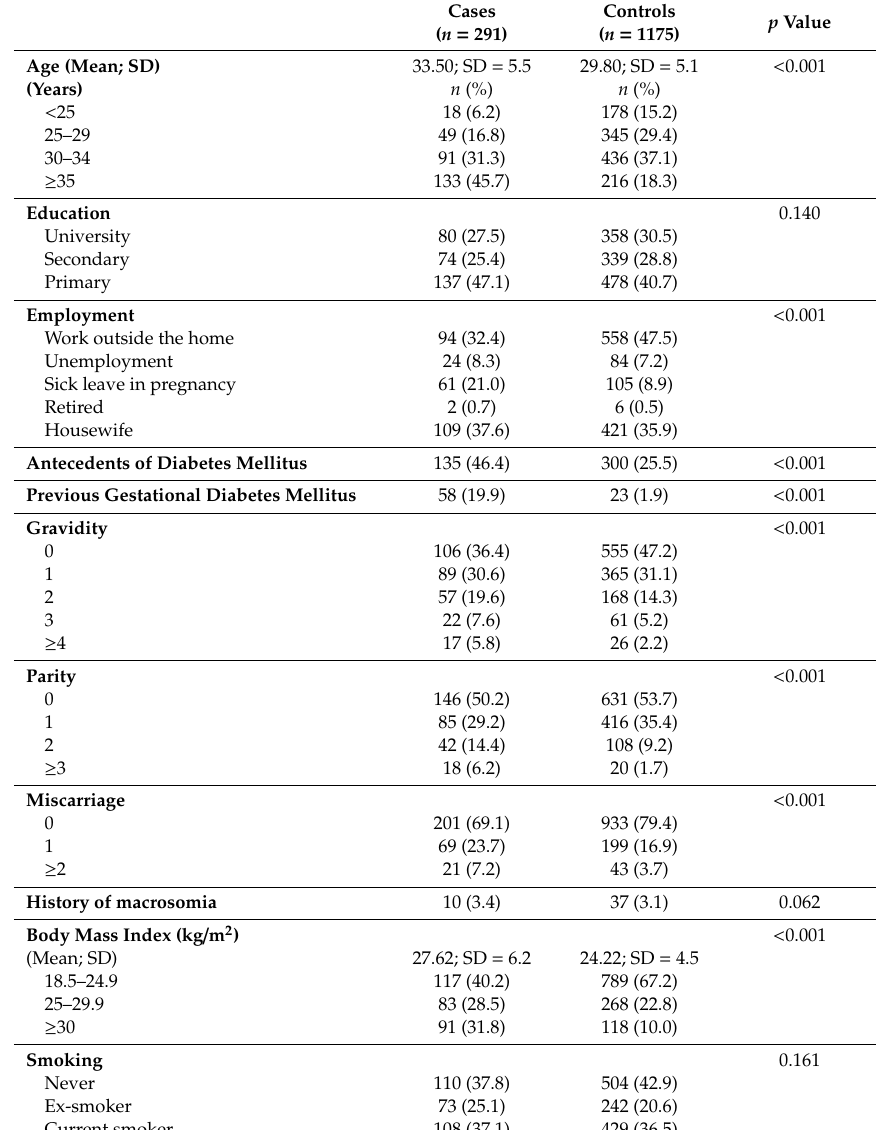
Table 1. Description of cases with gestational diabetes mellitus and the controls without gestational diabetes